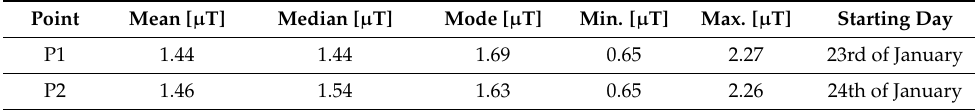
Figure 4. Measured field evolution over the 24 h ( left ) and its cumulative distribution function ( right ) for points P1 (pink trace) and P2 (green trace). Table 1. Measured field statistics and information for points P1 and P2.